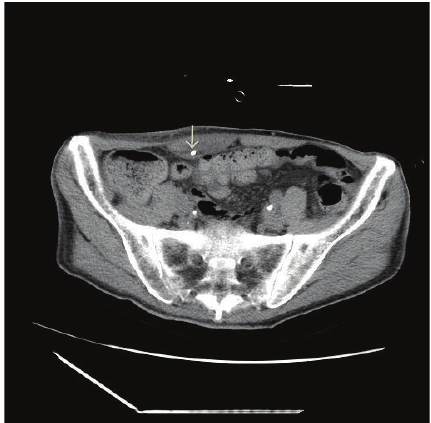
Figure 3: Axial computed tomography reveals the catheter in the right inferior epigastric vein as well as swelling of the right lower rectus abdominis muscle and adjacent subcutaneous